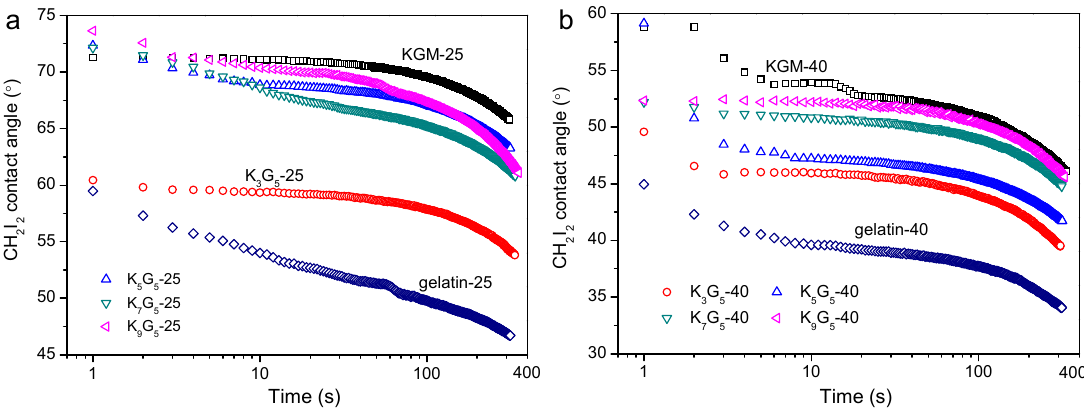
Figure 6. Variations in CH 2 I 2 contact angle with time for KGM, gelatin, and KGM / gelatin films prepared under drying temperatures of 25 °C ( a ) and 40 °C ( b ).